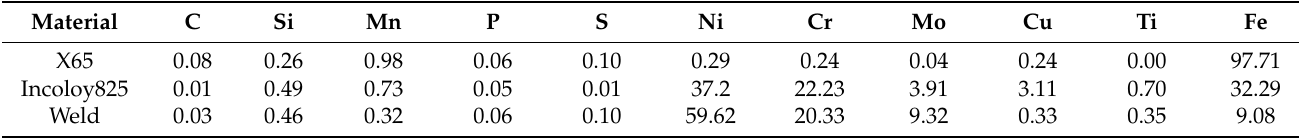
Table 1. Chemical compositions of Incoloy825, X65 and weld